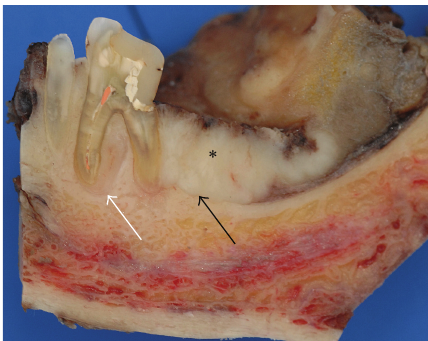
Figure 3: Case 1—cross section specimen. The black arrow high- lights the close relation of the distal root to the tumor mass ( ∗ ) with preserved cortical bone distal to the tooth. The white arrow points at atumorformationalongthemesialrootfillingouttheinterradicular